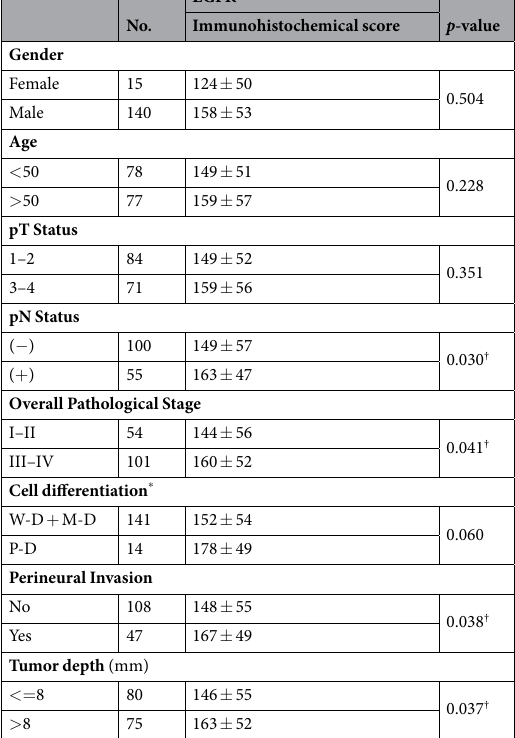
Table 1. Association of EGFR expression levels (immunohistochemical score) with clinicopathological characteristics in 155 untreated OSCC patients. * W-D: well-differentiated, M-D: moderately differentiated, and P-D: poorly differentiated squamous cell carcinoma. † Statistically significant.